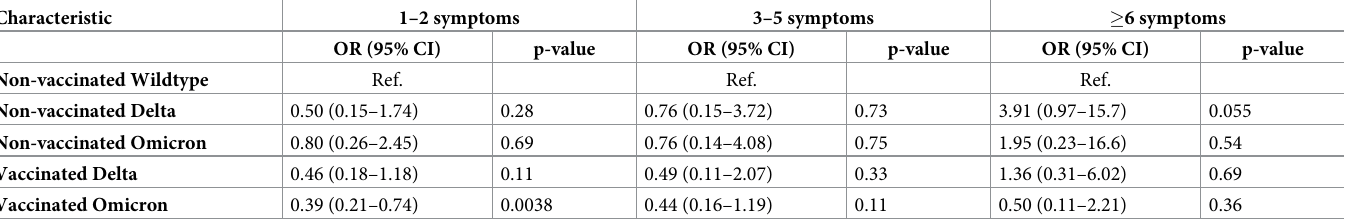
Table 2. Results from multinomial logistic regression analyses of the association of SARS-CoV-2 variant and vaccination with severity of post COVID-19 condition in terms of symptom count. Characteristic